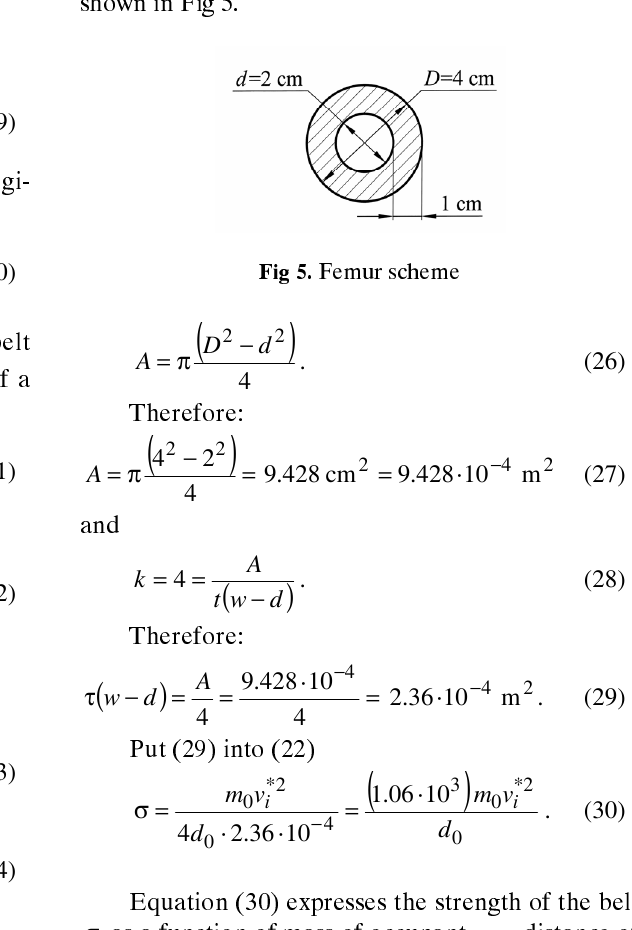
Fig 4. Seatbelt scheme